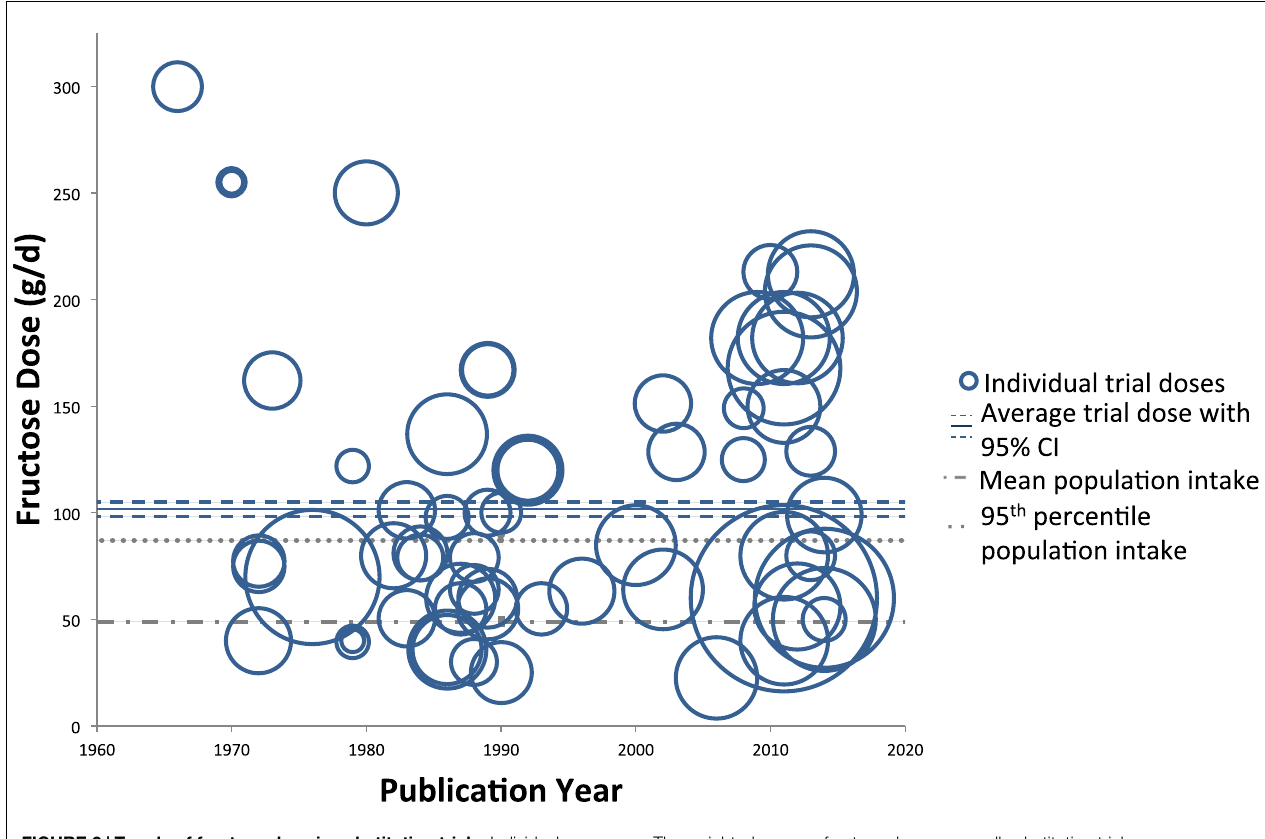
FIGURE 2 | Trends of fructose dose in substitution trials . Individual trials are plotted based on date of publication and fructose dose used. Sample size of each trial is represented by the size of its respective circle.